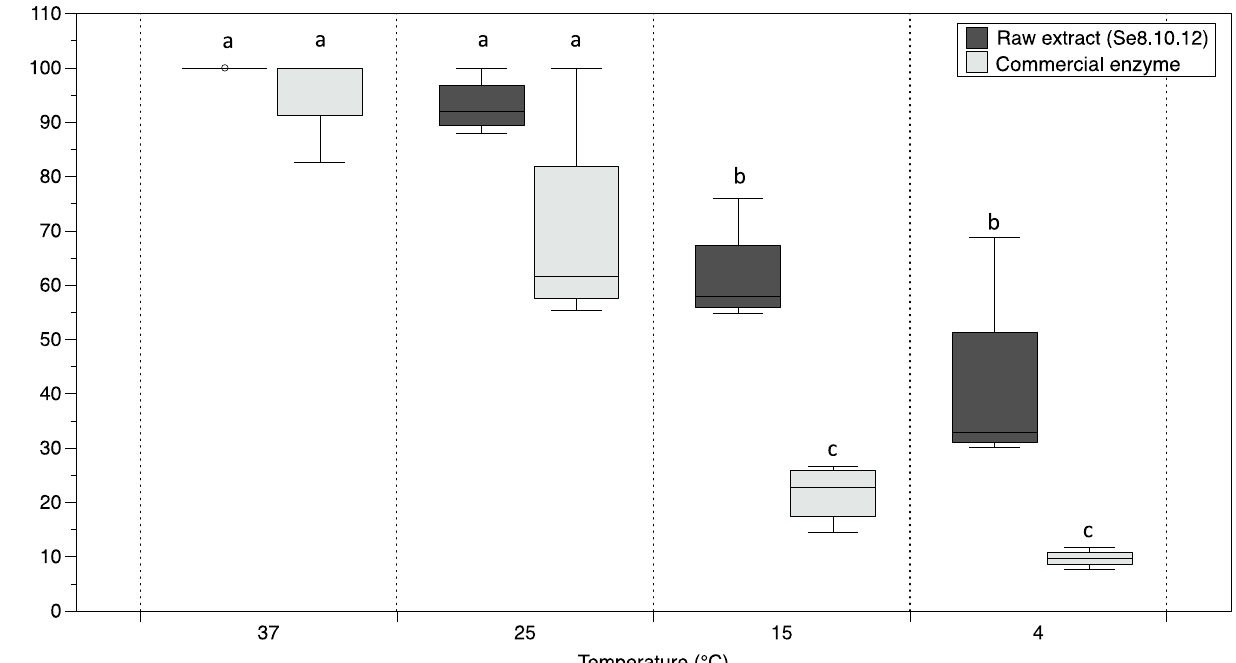
Figure 2. Boxplot representing the β -galactosidase relative activity from Antarctic strain Se8.10.12 crude extract ( Rahnella sp.) and commercial enzyme ( Aspergillus oryzae ) determined at 37 ◦ C, 25 ◦ C, 15 ◦ C, and 4 ◦ C after 12 h reaction with milk. The horizontal line indicates the mean values, and the length of each whisker indicates the interquartile range (IQR); n = 4. Different letters represent statistically significant differences (one-way ANOVA within temperatures, p < 0.005; t -student between enzymes, p < 0.01).